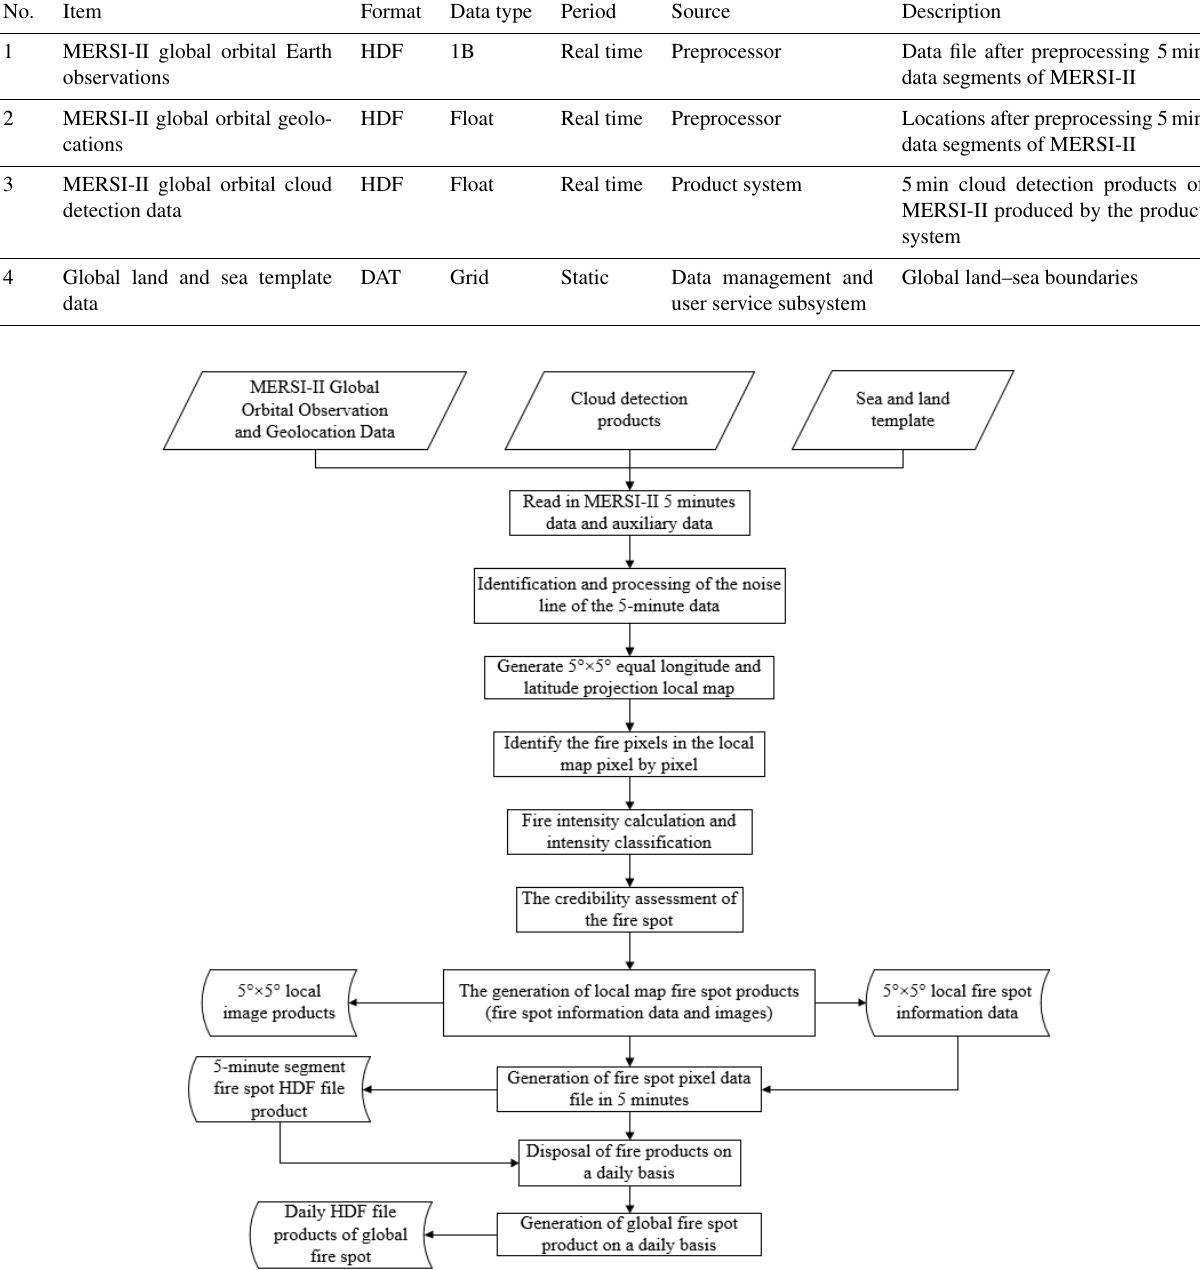
Figure 3. General flowchart for generating FY-3D MERSI-II fire spot